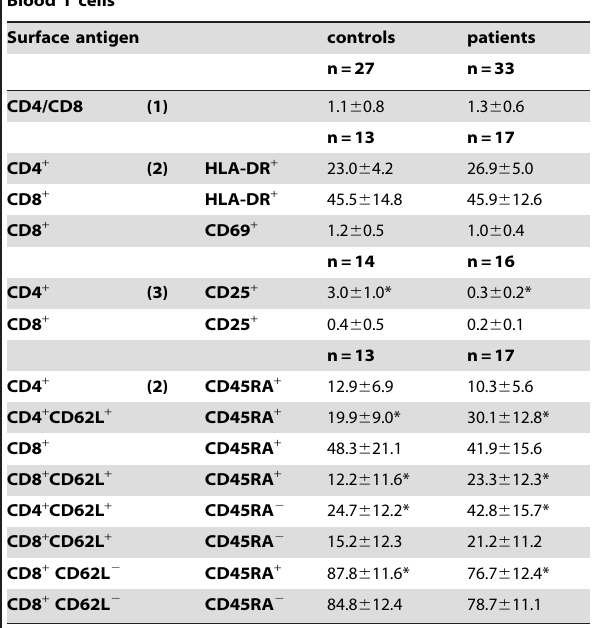
Table 3. T cells subsets (CD4 + /CD8 + ) and T-cell